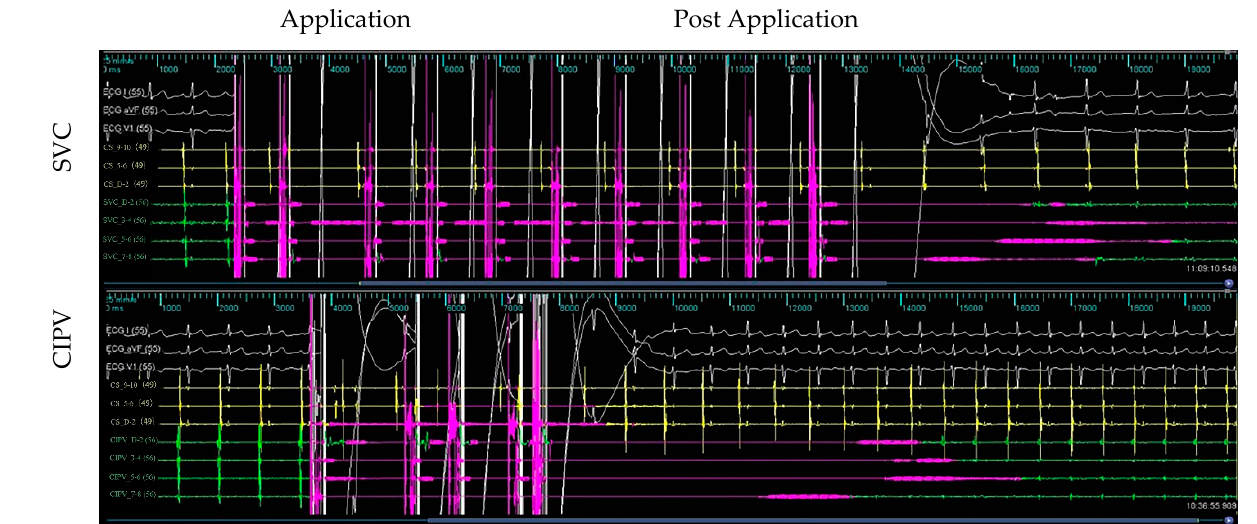
Figure 3. Acute isolation of the SVC and CIPV. PFA is recorded from bipolar electrograms from the 10-electrode array; the PFA catheter is placed in the ostial of the SVC and CIPV. Electrogram signal reduction in the SVC and CIPV with PFA across the CIPV and SVC ostial treatment targets, only far-field signals remained. Complete electrical isolation of all structures was confirmed by the entrance block. White color for ECGI, avF, V 1 leads; yellow color for coronary vein sinus electrode potential; green color for PFA catheter electrode potential.